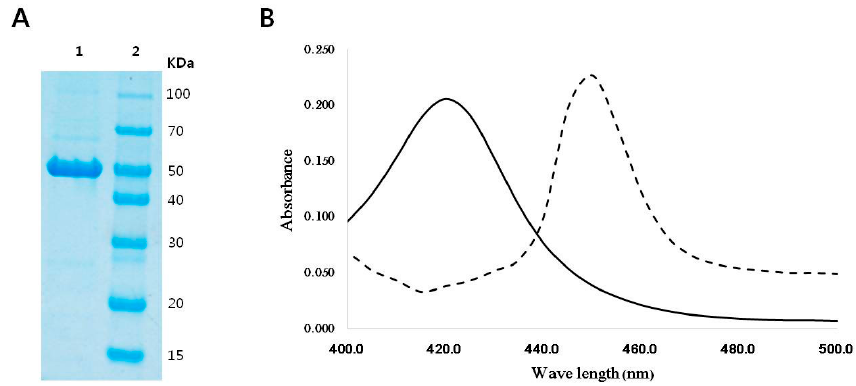
Figure 1. ( A ) Purification of CYP153D17: Lane 1 , purified CYP153D17; Lane 2 , molecular marker; ( B ) CO-reduced spectra of heterologously overexpressed CYP153D17. Oxidized form, solid line; CO-reduced form, dotted line.